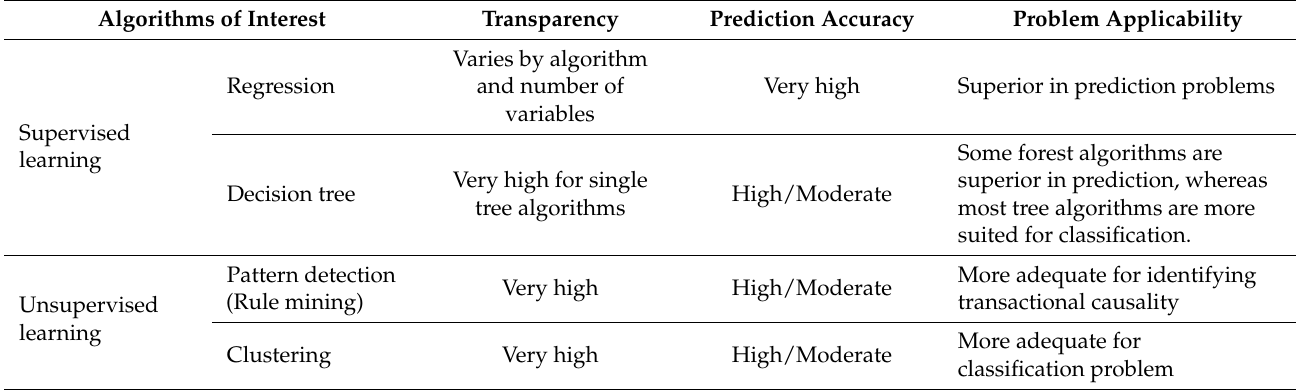
Table 1. Comparison of transparent